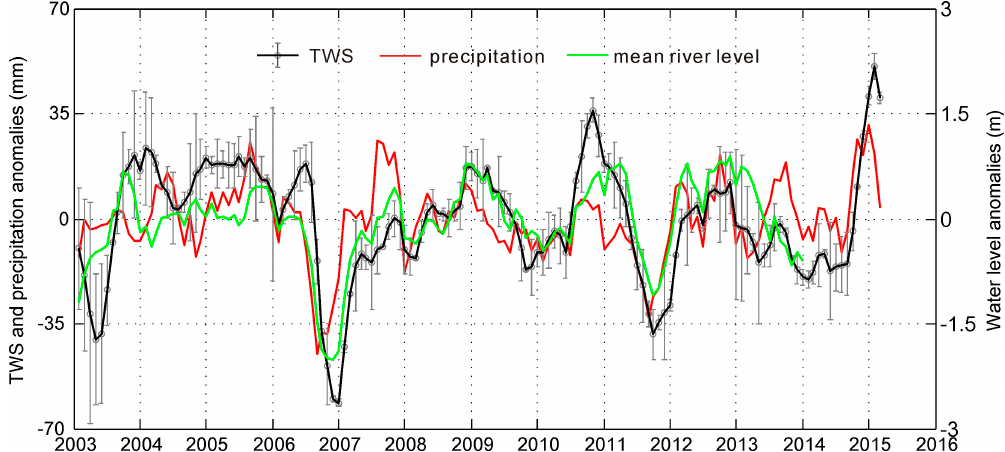
Figure 5. Figure 5. Time series of non-seasonal variations in TWS, mean river level and precipitation within the Sichuan Basin. The error bars show the uncertainties of GRACE data, represented by the standard deviation of non-seasonal TWS difference between CSR and GFZ